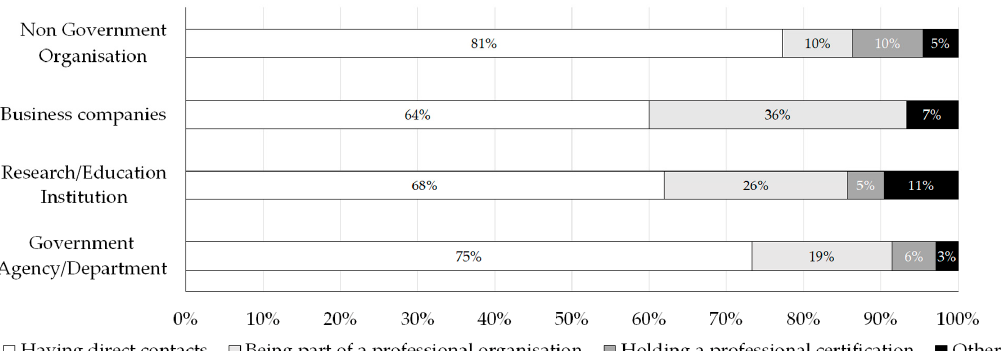
Figure 5. Selected factors needed to start a collaboration with other stakeholders. Percentages of respondents of each category are shown for the suggested items.